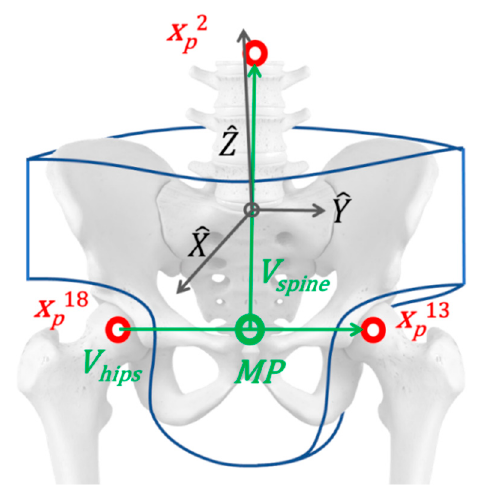
Figure 8. Kinematic conversion of the pelvis segment (in blue). The nodes from the M-K system are in red. The computed vectors and points are in green. The segment’s local reference system are in black.